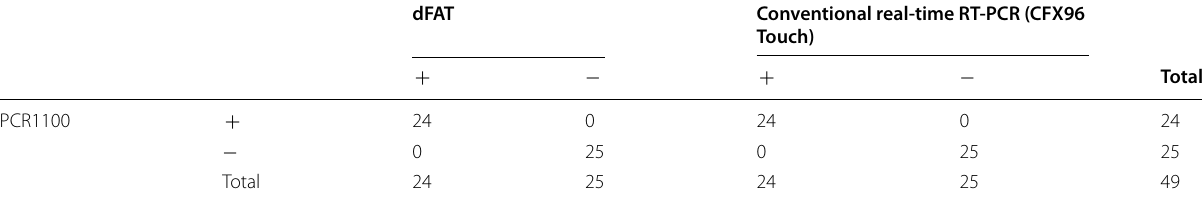
dFAT direct fluorescent antibody test